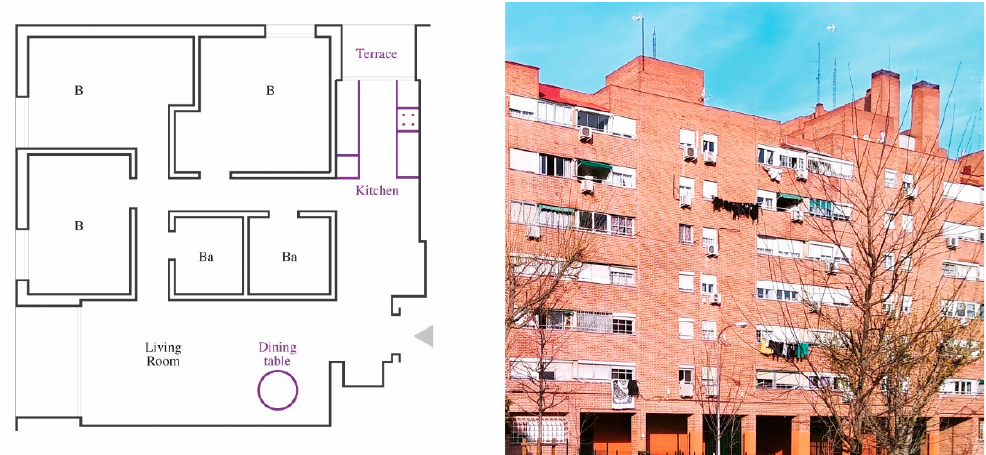
Figure 6. Houses along Palomeras Park, UD 2 mega-block. Three-bedroom apartment. Plan redrawn and photo by author.